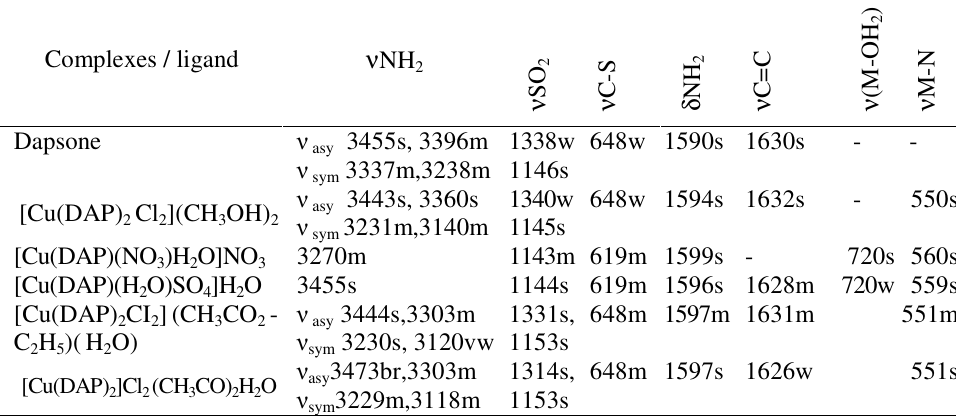
Table 1 . Infra-red Spectra of 4, 4-diaminodiphenylsulphone and its complexes.